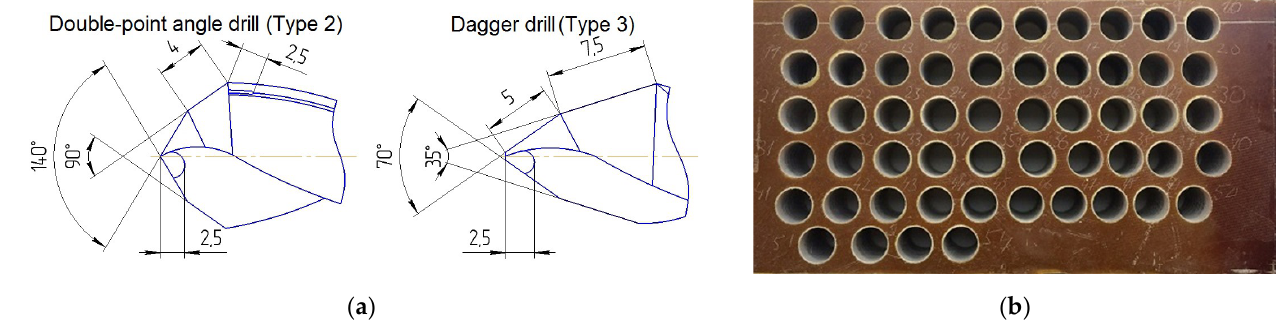
Figure 2. Geometry of modified drills ( a ); ( b ) view of the sample with drilled